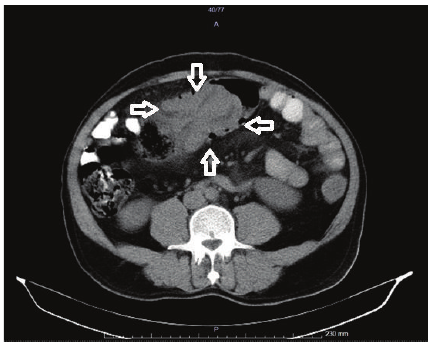
Figure 1: Tomographic view of the intussuscepted transverse colon.